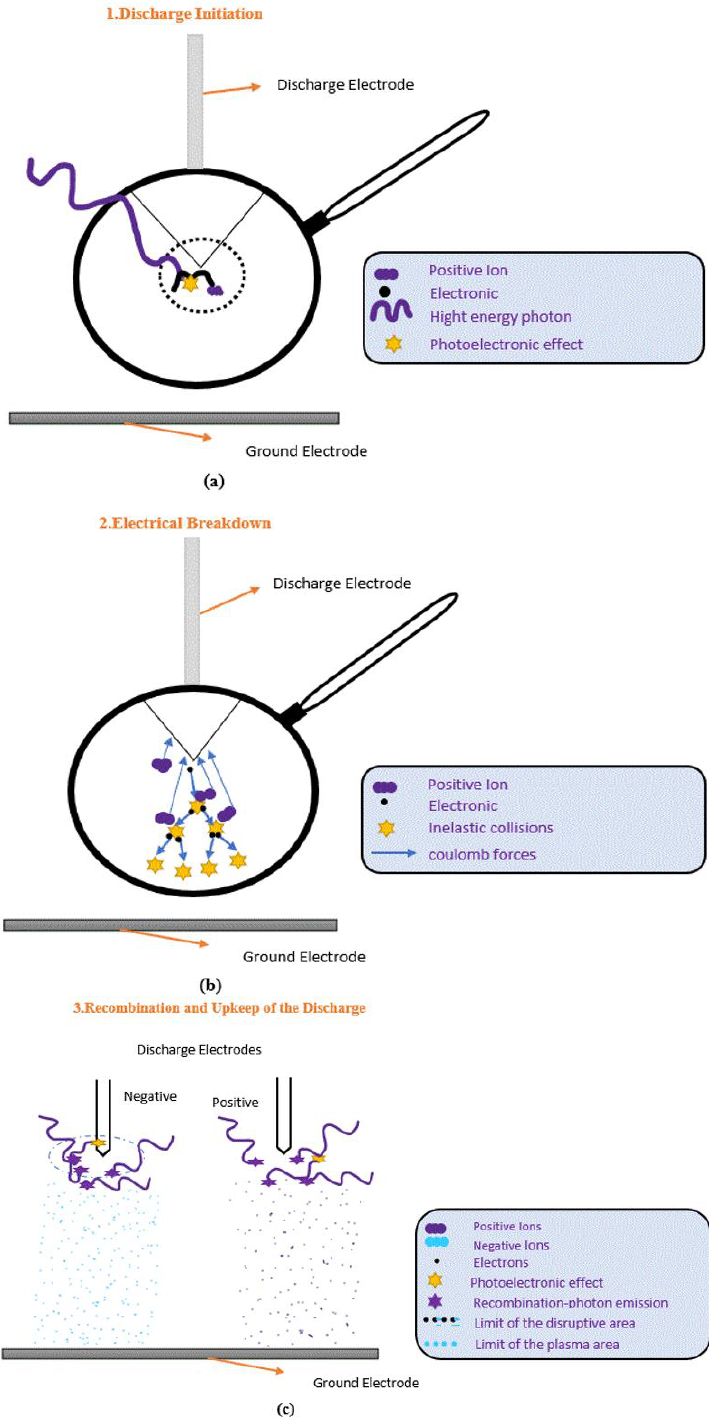
Figure 1. ( a – c ) A corona discharge is a phenomenon that occurs in the air [2].